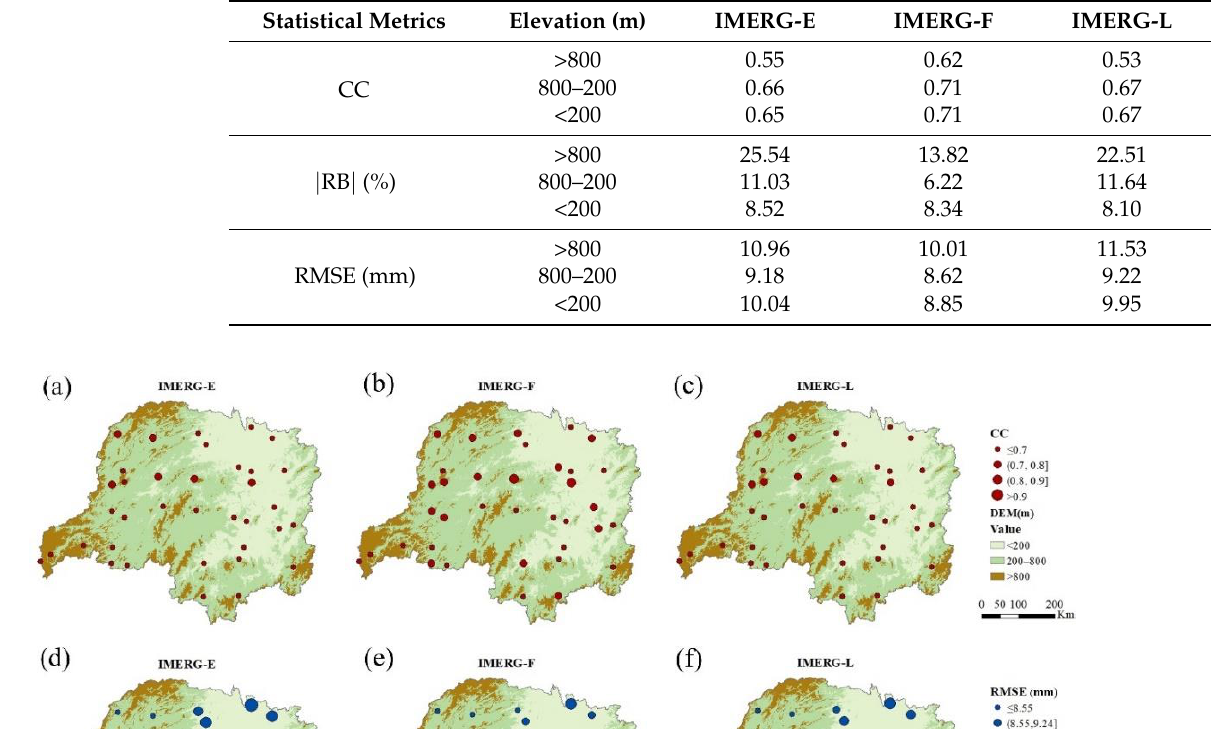
Table 2. Comparison of the daily precipitation between IPPs and observed precipitation values and calculation of the average of three statistical indicators related to elevation from September 2014 to February 2021.